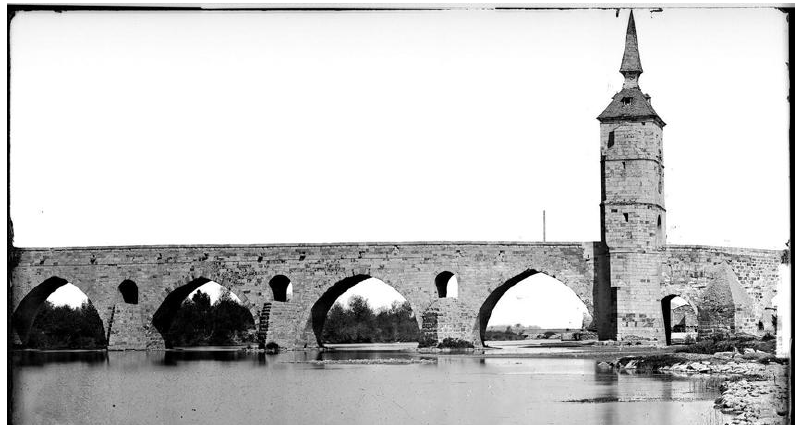
Figure 2. Bridge over the Duero river in Zamora, photograph acquired by J. Laurent, in 1870. Photograph of the southern half (arcs